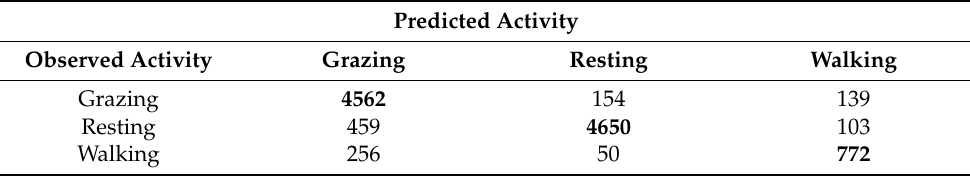
Table 4. Confusion matrix of the best classifier using random forest, showing the predicted activity for neck collar-mounted accelerometers recording activity of six sheep during four sampling days (5 s epochs). Values across the diagonal (bold) represent those activities that were correctly identified, true positives. Values in the matrix are the number of epochs.